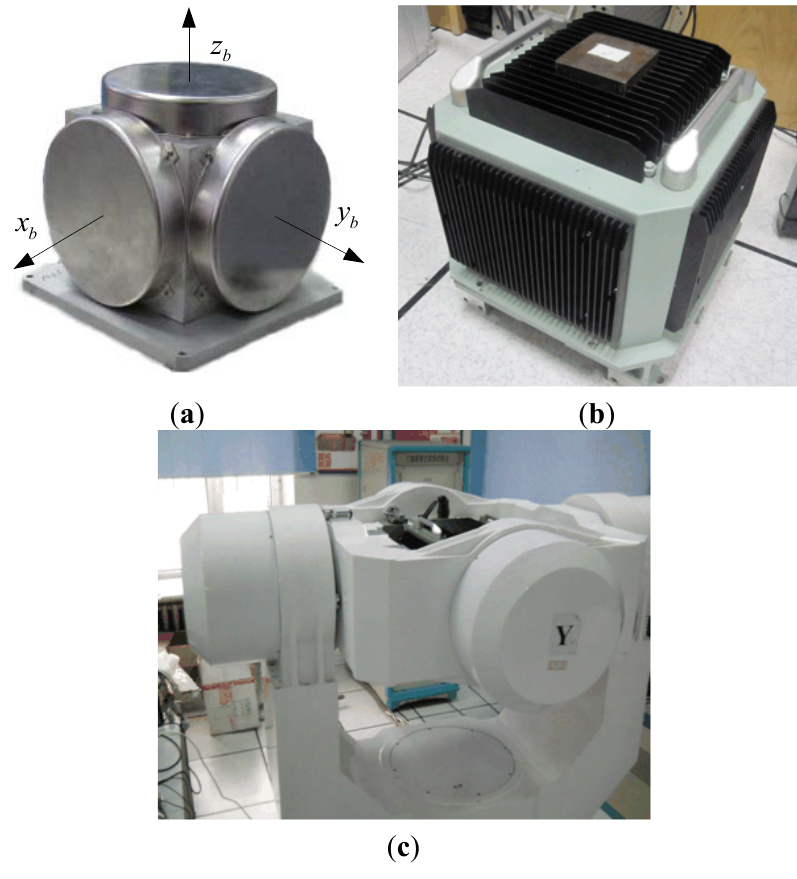
Figure 12. ( a ) Self-made IFOG-IMU and its body frame; ( b ) IFOG-IMU based strapdown INS; ( c ) STG-3 turntable and the experiment scene.